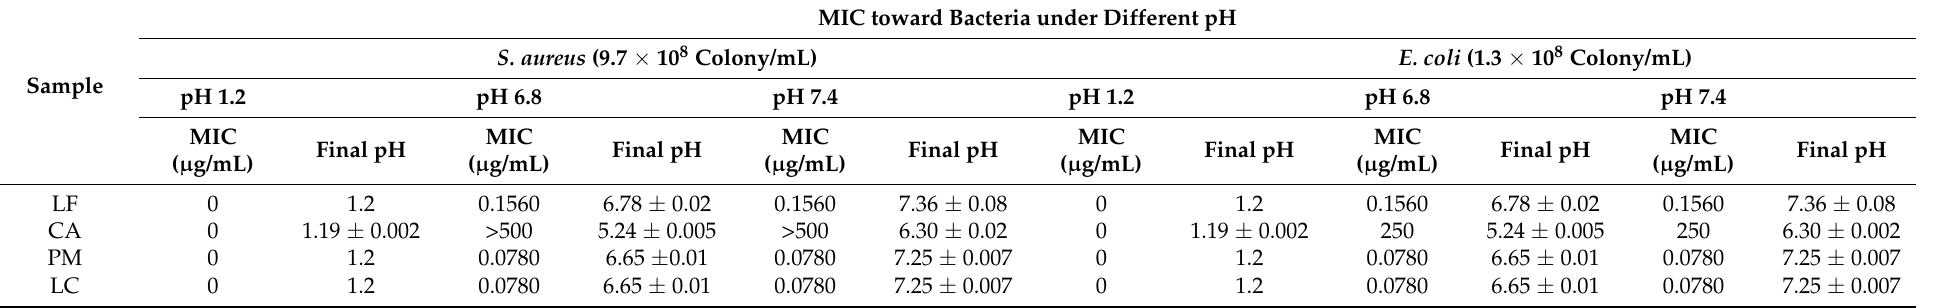
Table 3. Minimum inhibition concentration (MIC) of levofloxacin citrate (LC) compared to levofloxacin (LF) and physical mixture (PM) of levofloxacin and citric